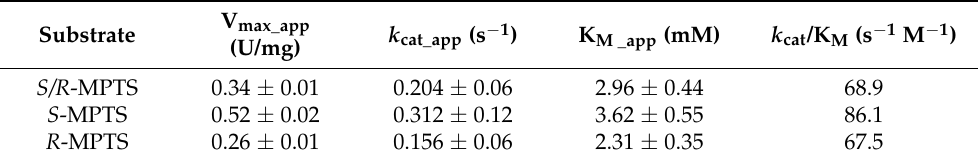
Table 3. Kinetic properties of H. influenzae rMsrAB in thioredoxin/thioredoxin reductase-based assays using MPTS as the substrate.